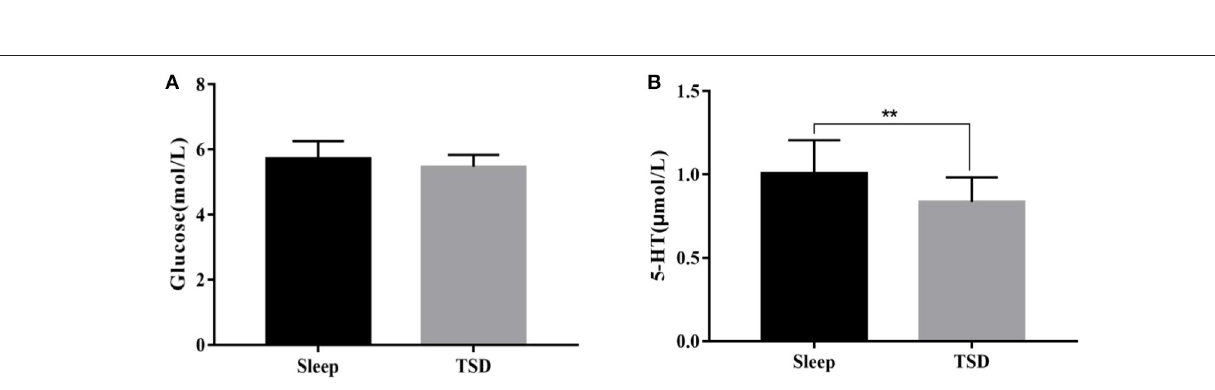
Frontiers in Psychology |